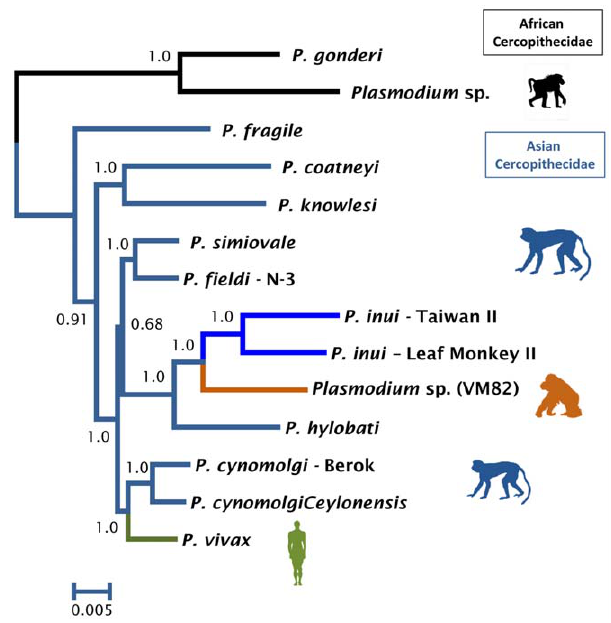
Figure 1. Phylogenetic tree of orangutan Plasmodium based on complete mitochondrial genomes. Bayesian and maximum likeli- hood methods yield identical topologies so only the Bayesian tree is shown. The values above branches are posterior probabilities together with bootstrap values (in bold) as a percentage obtained for the maximum likelihood tree (see